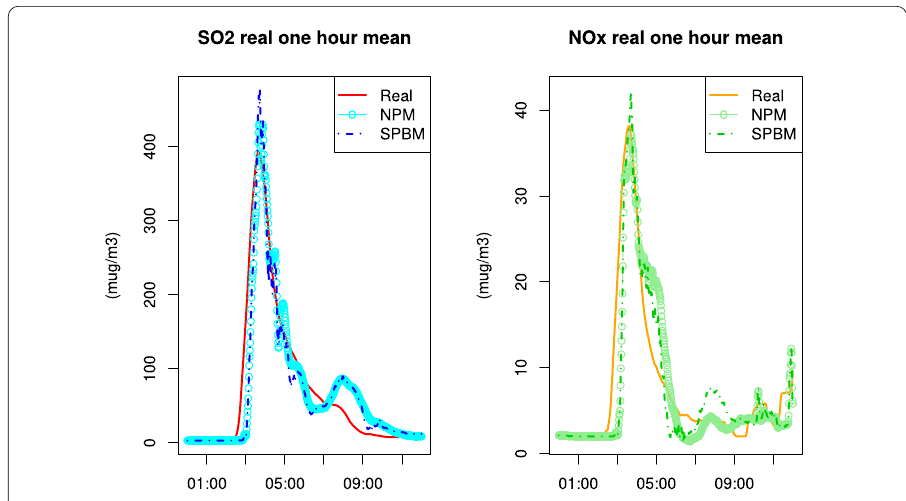
Figure 5 Episode depicted in one of sampling stations. Predictions given by the bidimensional semiparametric models for the one hour SO 2 (left) and NO x (right) means